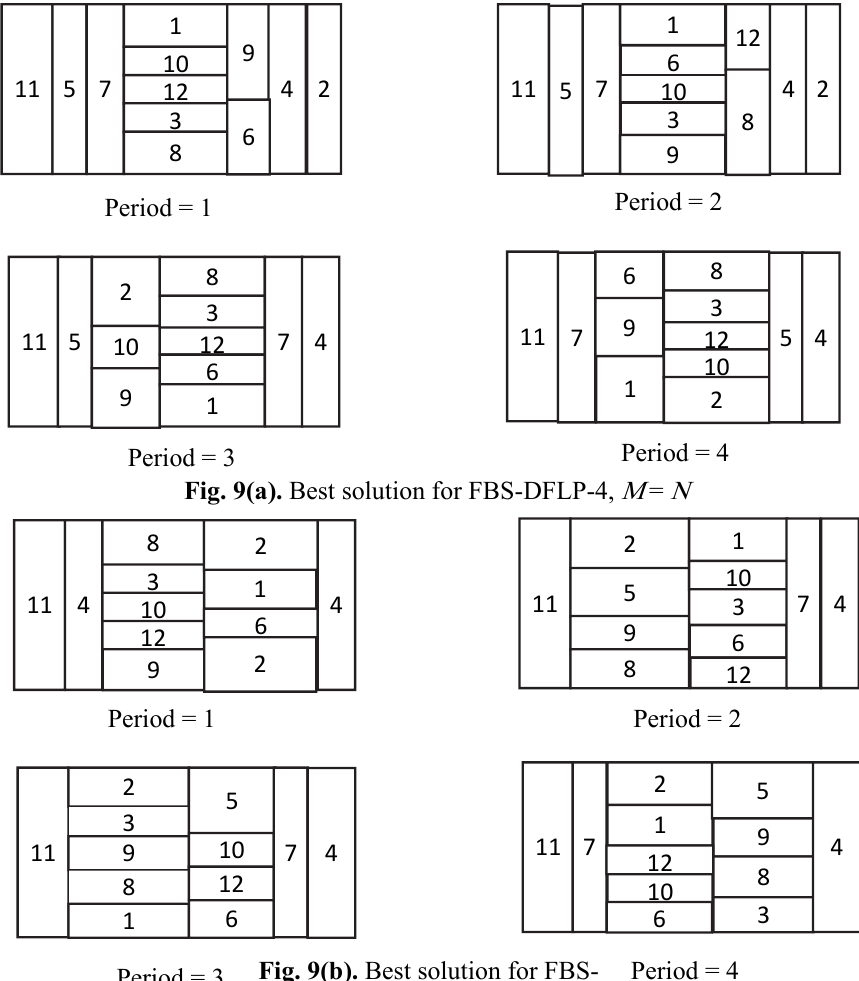
Fig. 9(b). Best solution for FBS- Fig. 9. Best layouts found for FBS-DFLP-4 with M = N and FBS-DFLP-4 with M = 5 problems